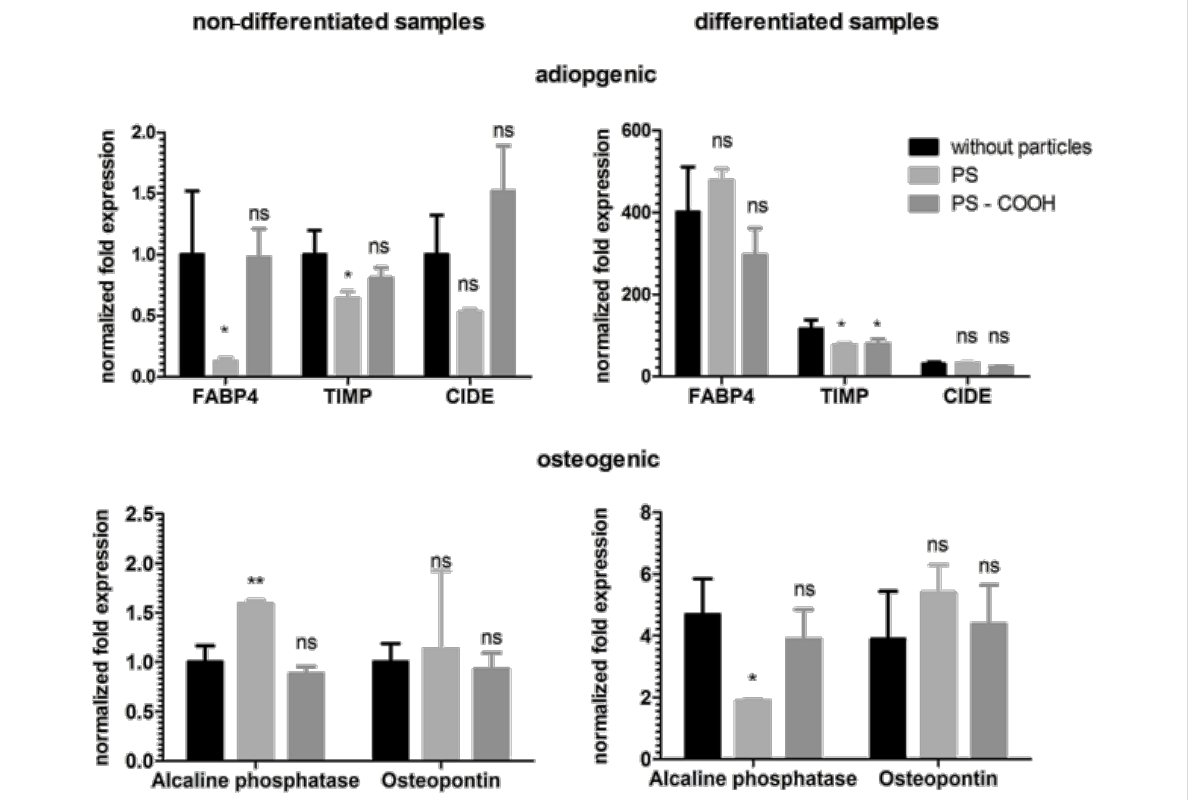
Figure 6: Influence of polystyrene nanoparticles (PS and PS–COOH) on the expression of adipogenic and osteogenic marker genes in hMSCs. Expression was analyzed with qPCR, using GAPDH and B2M as an internal control. The normalized fold expression was calculated with the ΔΔ C T method, assigning the non-differentiated sample without particle as a control. p > 0.05 ns, p < 0.05 *, p > 0.01 **; FABP4: fatty acid binding protein 4; TIMP: tissue inhibitor of metalloproteinase; CIDE: cell death inducing DFFA-like